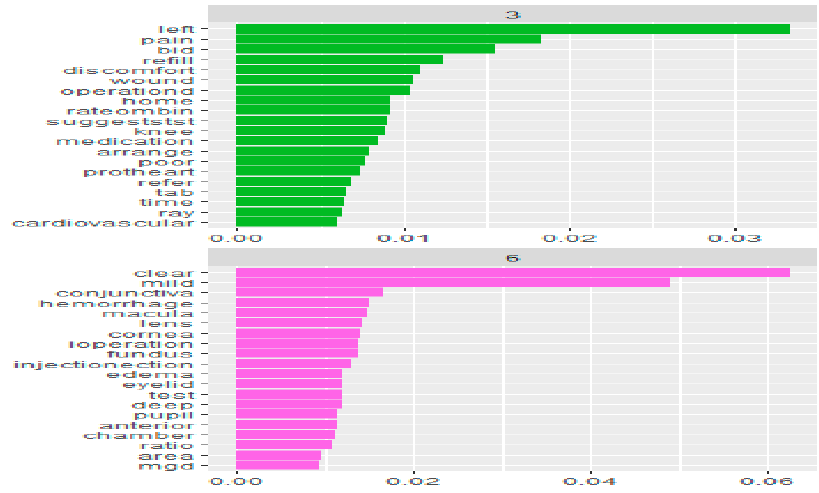
Figure 8. Word frequency distribution of 20 words in six topics (E11 Topic 3 and 6).